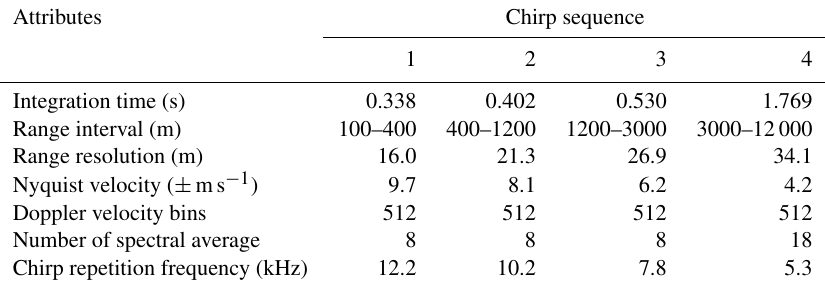
Table 2. Main settings of the chirp sequence used during TRIPEx for the W band radar. See Küchler et al. (2017) for a detailed description.